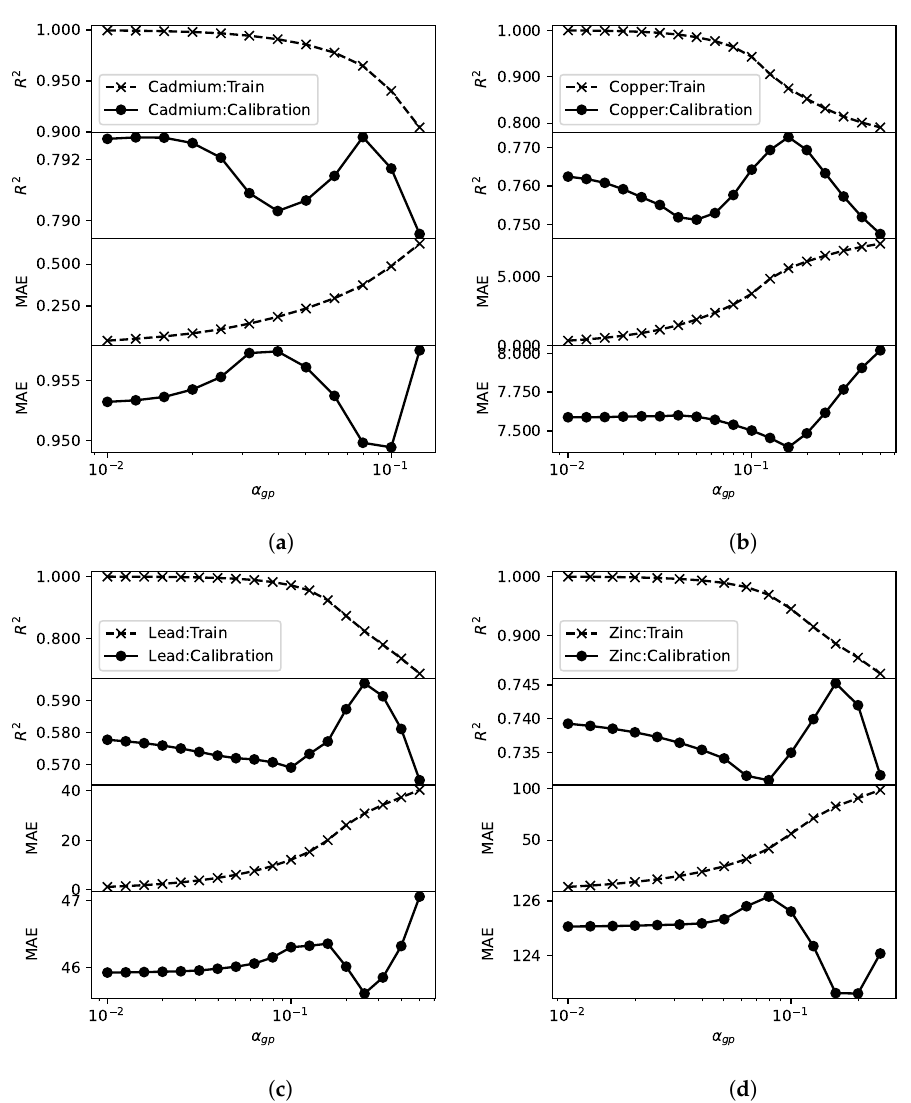
Figure 9. Bias-variance trade off. ( a ): Cademium; ( b ): Copper; ( c ): lead; ( d ):